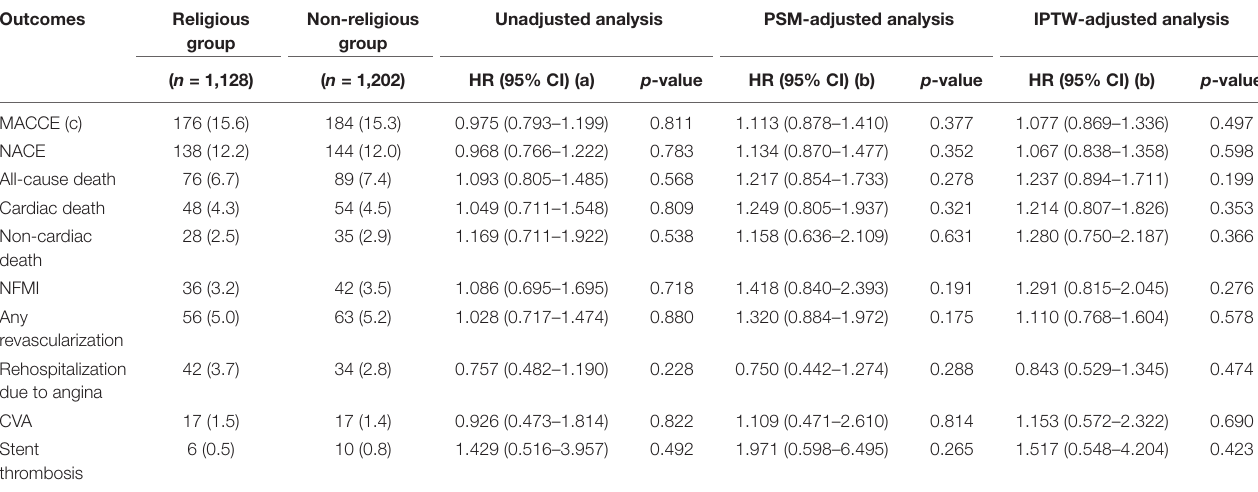
TABLE 3 | One-year clinical outcomes in propensity score matched post-discharge survivors.